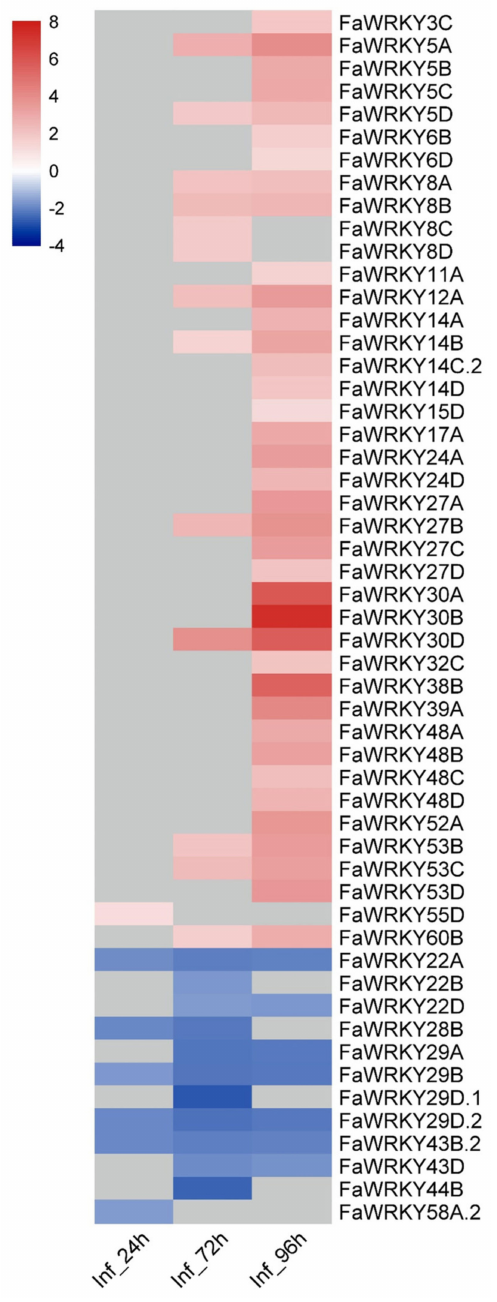
Figure 10. Heatmap of differentially expressed FaWRKY genes in response to C. fructicola infection in leaves. Changes of gene expression in infected strawberry (Inf_24h, Inf_72h, Inf_96h; 24, 72 and 96 h after spore inoculation, respectively) vs. mock-inoculated strawberry are represented as log2 fold change if absolute values were >1 (padj < 0.01), in a color scale from lowest (blue) to highest (red). Otherwise, they were colored